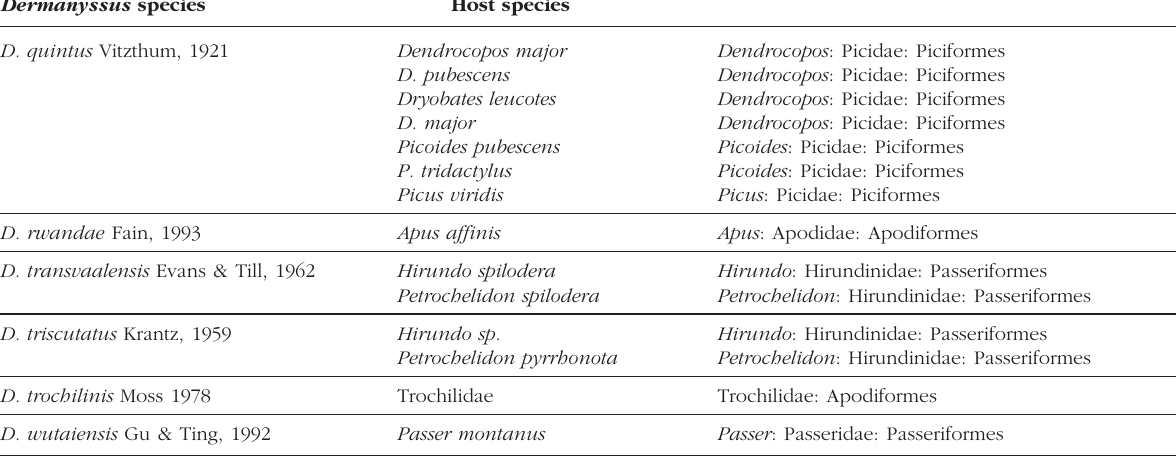
Table II. – List of species currently included in Dermanyssus and their known host species, established with the help of following refe- rences: Berlese & Trouessart (1889), Bory de Saint-Vincent (1828), Dusbabek & Cerny (1971), Evans & Till (1962), Evans & Till (1964 ), Ewing (1922, 1933), Fain (1993), Fend’a & Schniererová (2004), De Geer (1778), Gu & Ting (1992), Haitlinger (1987), Hermann (1804), Krantz (1959), Moss (1966), Moss (1978), Moss (1970), Nelson & Furman (1967), Nosek & Lichard (1962), Schrank (1776), Uchikawa & Kitaoka (1981), Uchikawa & Takahashi (1985), Vitzthum (1921), Zeman (1979), Zeman & Jurík (1981), Zemskaya (1971), Fend’a (2006, unpublished data) and collection data from Pr. A. Fain. Taxonomic bird data follow